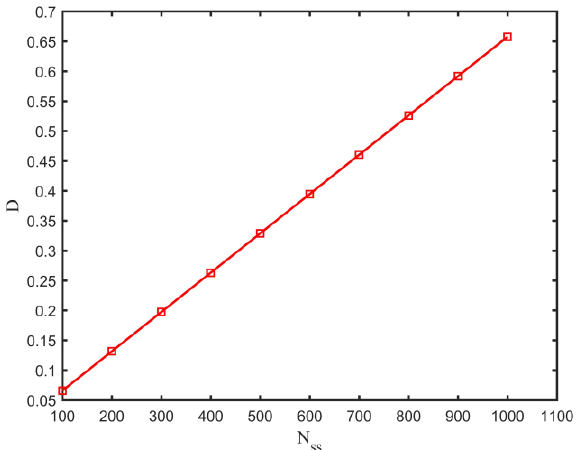
Figure 11. The fatigue damage for various numbers of start-up and shut-down cycles.